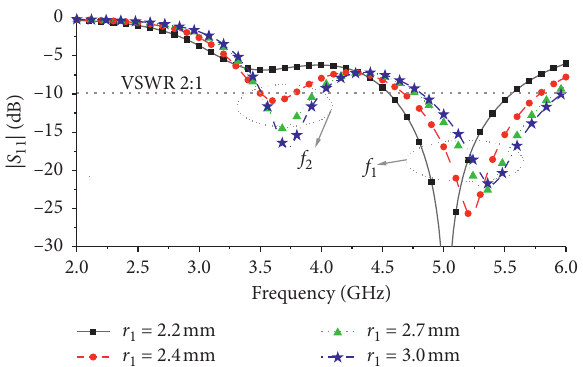
Figure 3: Variation of | S 11 | for Design 1 with respect to r 1 .